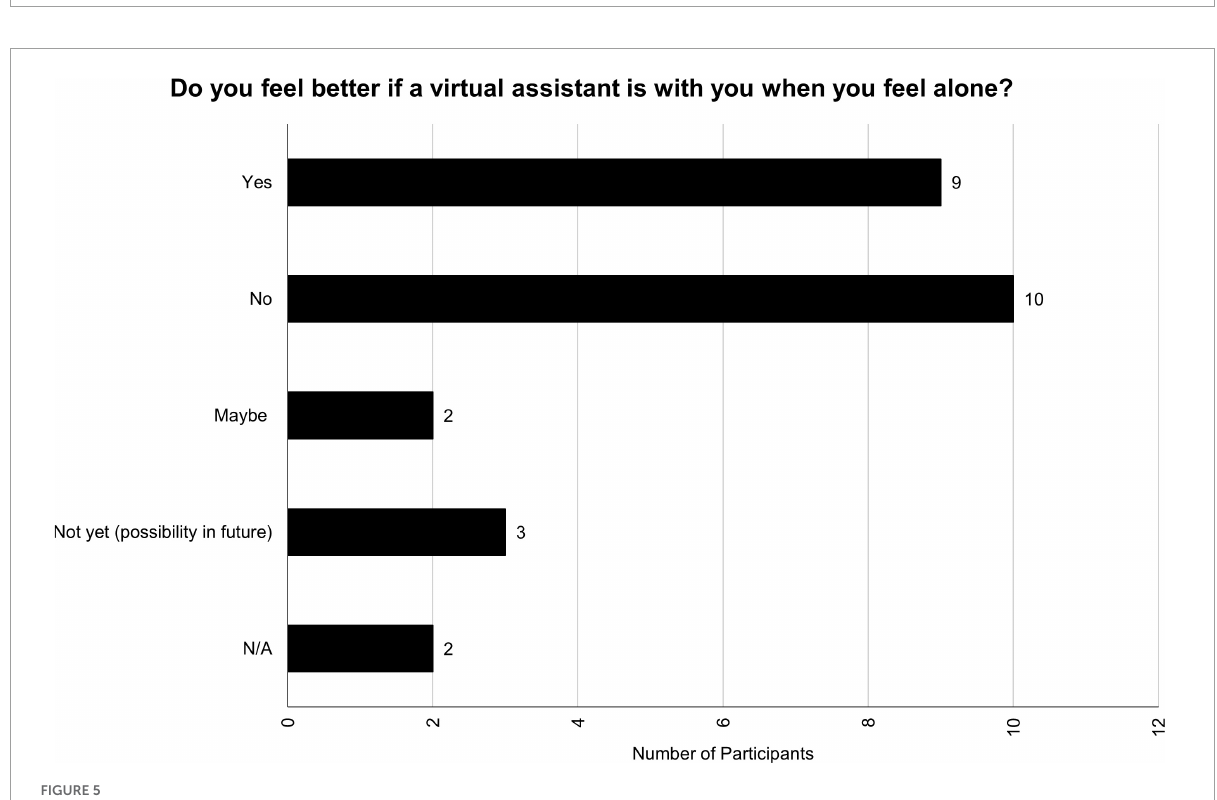
FIGURE4 Could a virtual assistant be your playfellow?